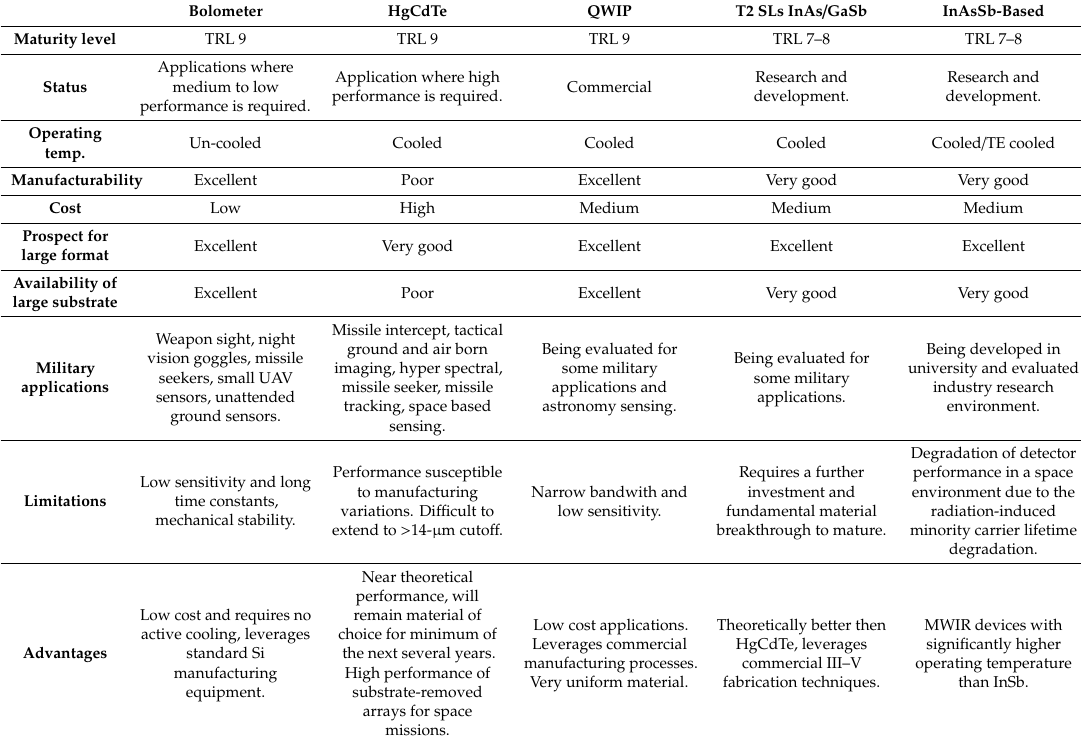
Table 8 gathers the LWIR detectors state of the art fabricated from selected materials. The highest level of maturity (technology readiness level, TRL = 9) is credited to HgCdTe photodiodes, microbolometers, and for QWIPs. The T2SLs InAs / InAsSb structures have proven the potential for MWIR and LWIR applications with performance comparable to HgCdTe for the same λ cut-o ff . Strong progress toward mature SLs and barrier detector technologies, including their commercialization, has been observed in the last decade. It is expected that InAsSb-based materials strengthen dominant position of InSb especially in MWIR FPA market in volume due to “ibility” advantages of III-V semiconductors. HgCdTe detectors allow one to reach lower dark current and HOT conditions and are / will be a material of choice for more demanding applications. Table 8. LWIR device state-of-the-art. TRL-technology readiness level (TRL = 10 ideal maturity). Bolometer HgCdTe